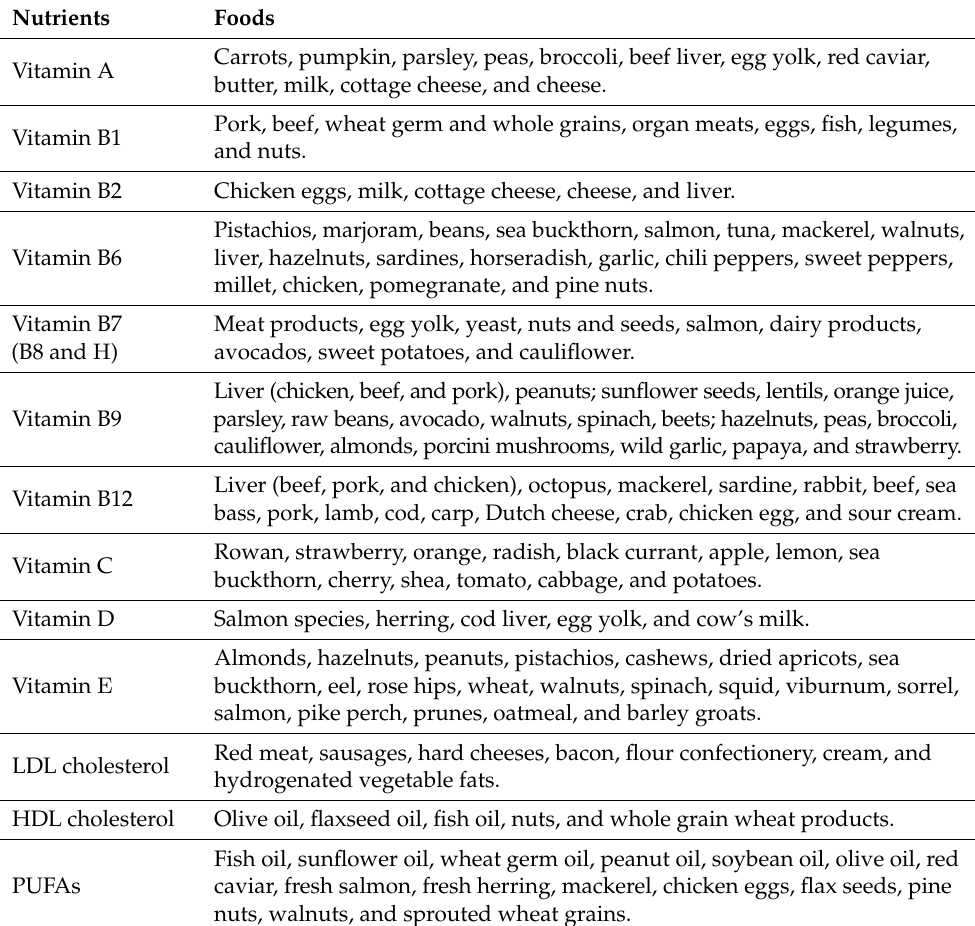
Table 2. Foods containing nutrients reducing the risk of developing amyotrophic lateral sclerosis